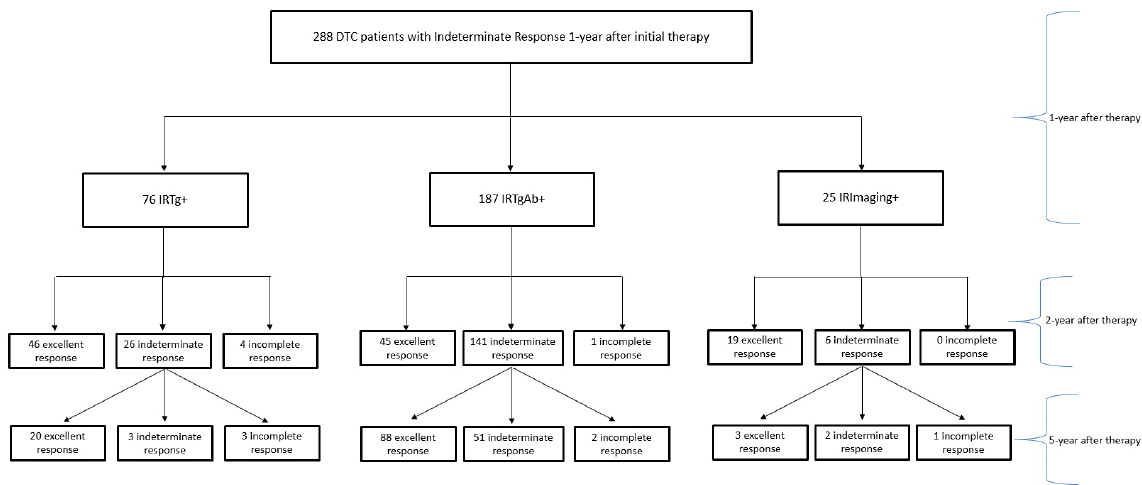
Figure 2. Flowchart of disease evolution over the years.